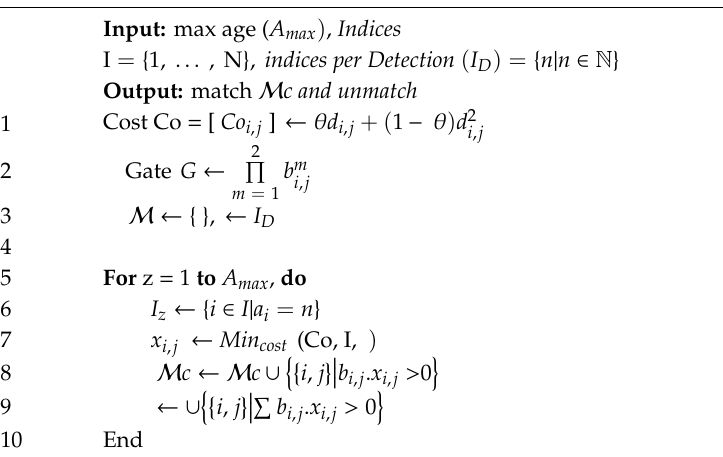
Algorithm 1: Human